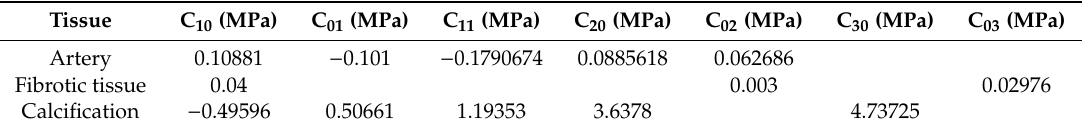
Table 1. Material coe ffi cients.